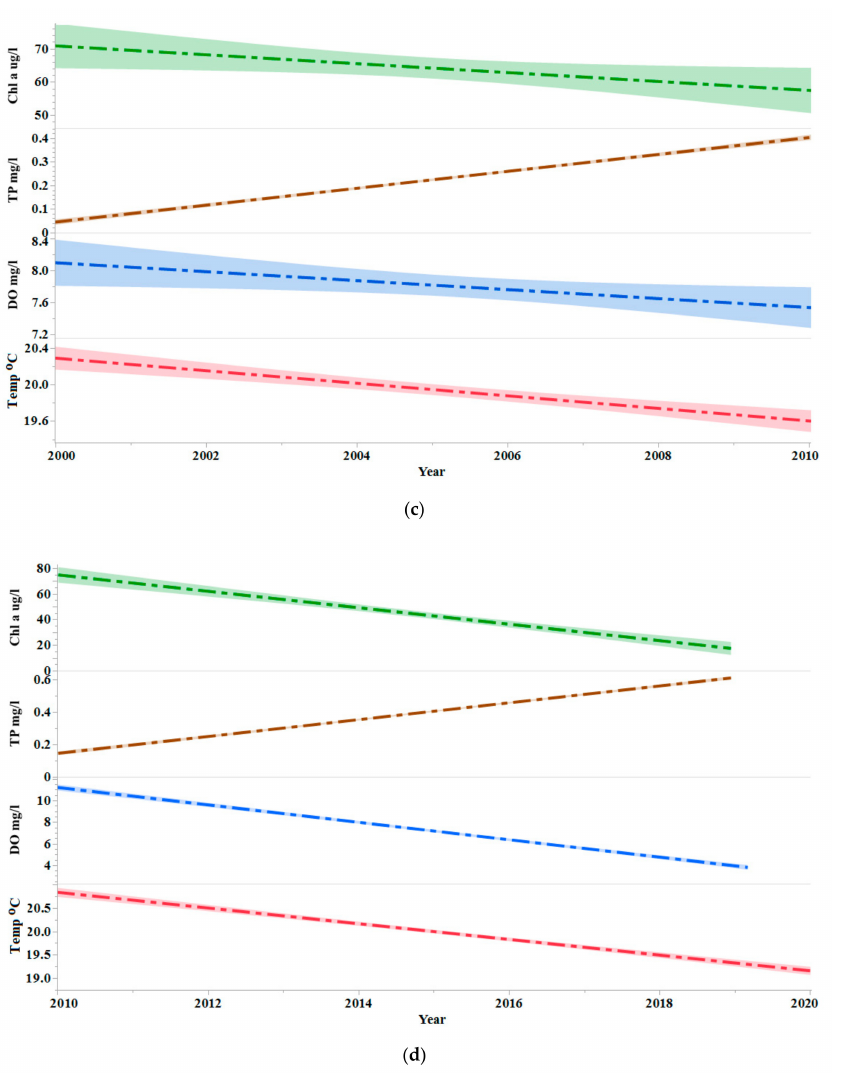
Figure 4. Decadal trends of chlorophyll-a, TP, DO and temperature in the Dam during ( a )